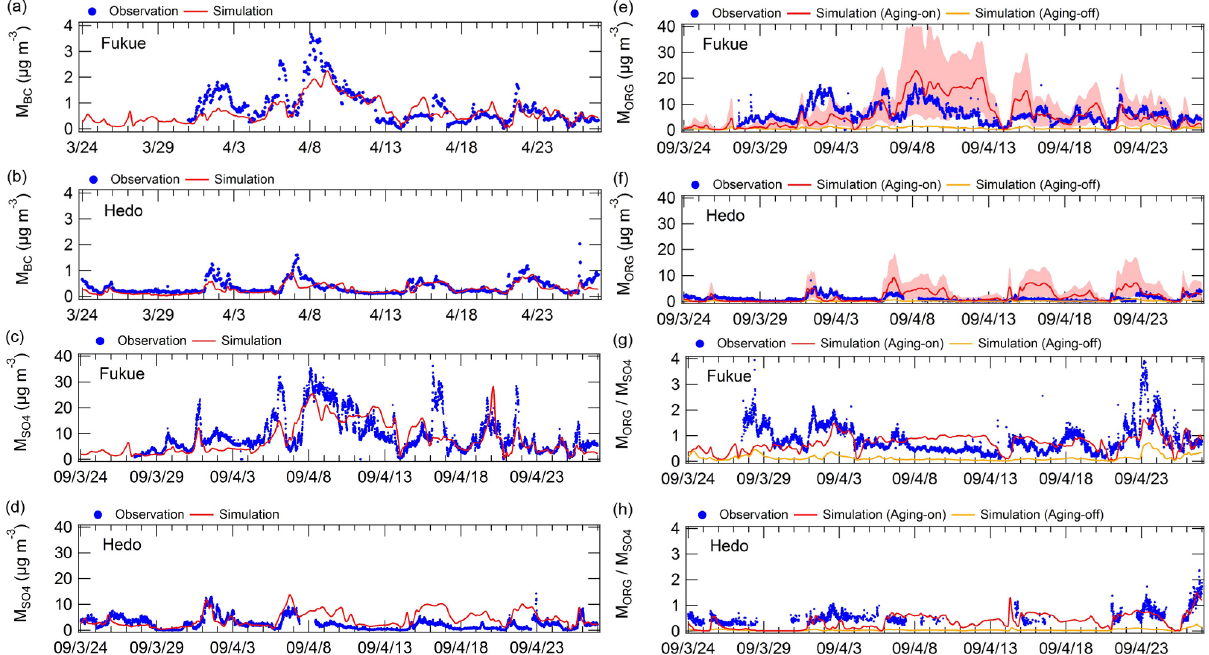
Figure 6. Time series of (a, b) black carbon mass concentrations, (c, d) sulfate mass concentrations, (e, f) organic aerosol mass concentra- tions, and (g, h) organic to sulfate mass concentration ratios at Fukue and Hedo, respectively. Red shading in (e) and (f) shows the range of organic aerosol mass concentrations with the aging coefficients of between 4 × 10 − 11 cm 3 molecule − 1 s − 1 (4 times the base case) and 2.5 × 10 − 12 cm 3 molecule − 1 s − 1 (0.25 times the base case). The periods when observed sulfate mass concentrations were less than 1µgm − 3 are not shown for measurements (blue points) in (g) and (h)